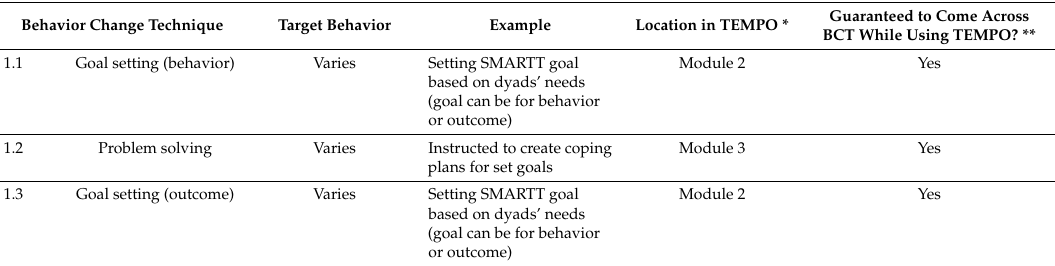
Table 1. Behavior Change Techniques incorporated into the TEMPO